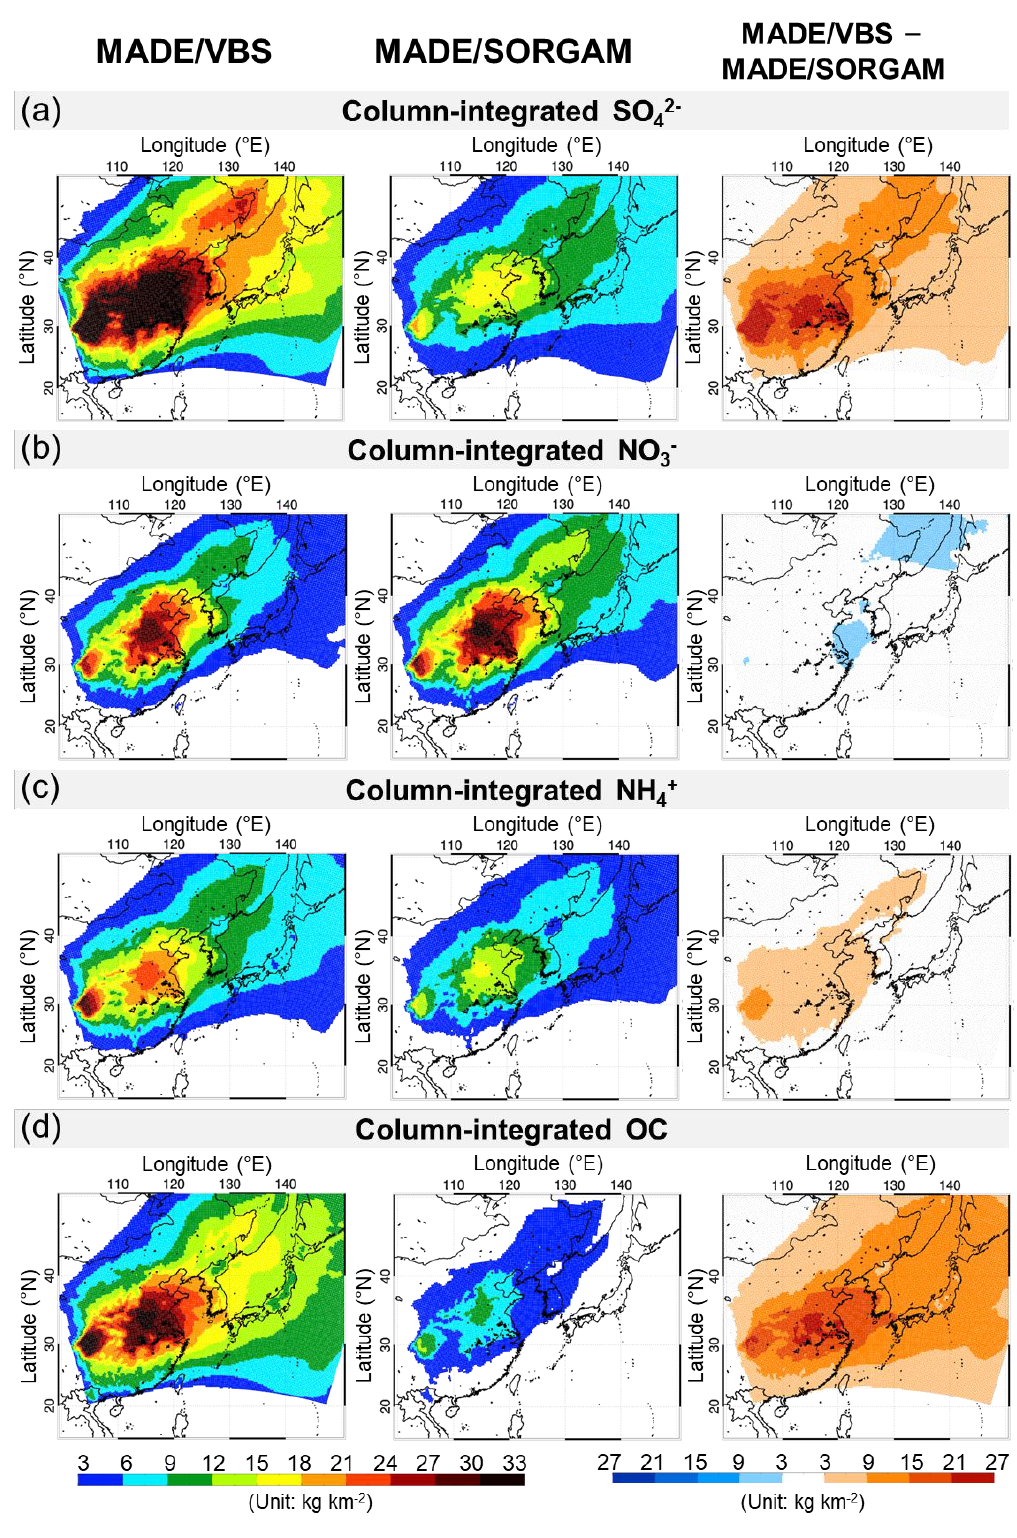
Figure 10. Comparisons of horizontal distributions for column-integrated species from two different aerosol modules. ( a ) SO 42− ; ( b ) NO 3− ; ( c ) NH 4+ ; ( d ) OC; and differences between two modules, MADE/VBS and MADE/SORGAM. Shown are results from MADE/VBS (left panel), MADE/SORGAM (middle panel), and differences between two modules (right panel).